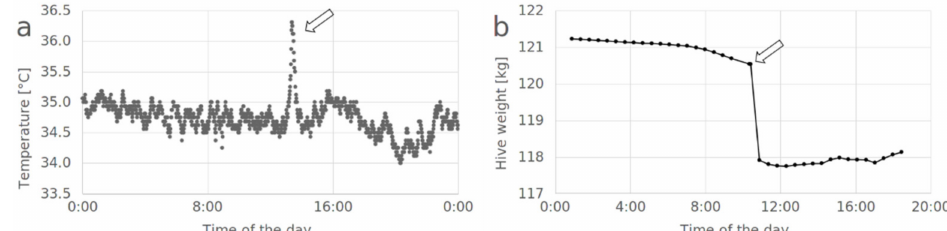
Figure 1. Examples for swarm detection based on in-hive temperature ( a ) and hive weight ( b ). Temperature was monitored every minute above the brood nest in a colony located in Jelgava, Latvia on 31 May 2018 with a temperature sensor (Dallas DS18S20, Maxim Integrated, San Jose, CA, USA). The weight of a hive located in Vecauce, Latvia was monitored every 30 min on 11 June 2021. Arrows indicate the departure of the